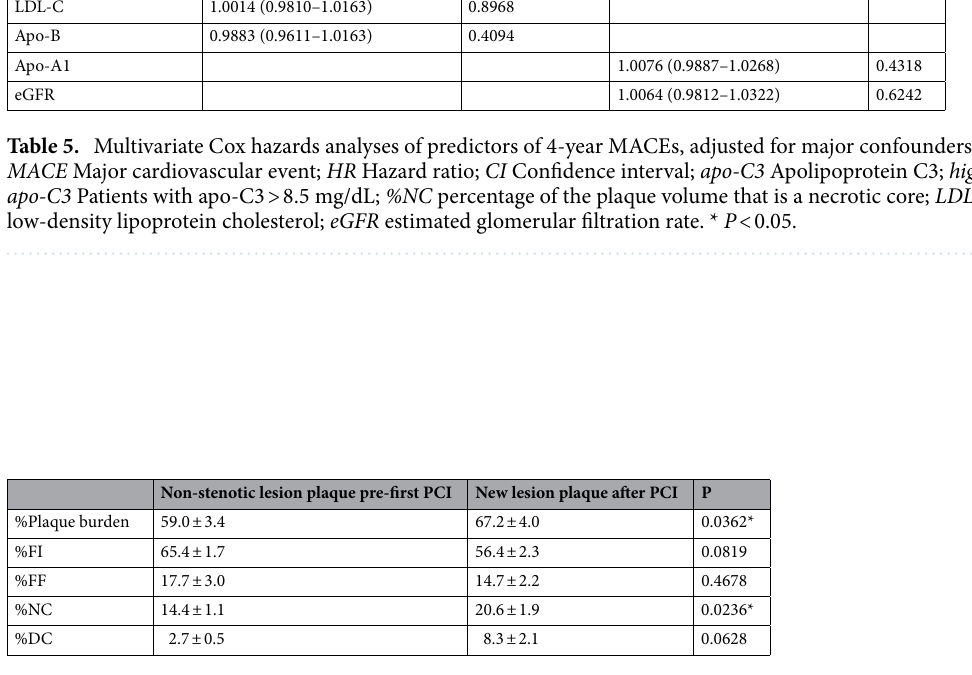
Table 6. Comparison of VH-IVUS data between the new lesion plaque at 9–12 months after PCI and the angiographical non-stenotic lesion plaque of his own pre-first PCI in the high apo-C3 group ( n = 5). Values are presented as mean ± standard errors. * P < 0.05 by paired t-test. Five new lesions in the high apo-C3 group could be estimated by VH-IVUS before PCI at 9–12 months after first PCI. VH-IVUS, virtual histology-intravascular ultrasound; %FI percentage of the FI volume in the plaque volume; %FF percentage of the FF volume in the plaque volume; %NC percentage of NC volume in the plaque volume ; %DC percentage of the DC volume in the plaque volume; high apo-C3, patients with apo-C3 > 8.5